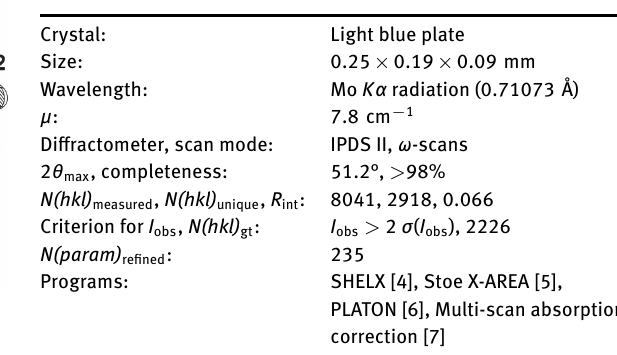
Table 1: Data collection and handling.